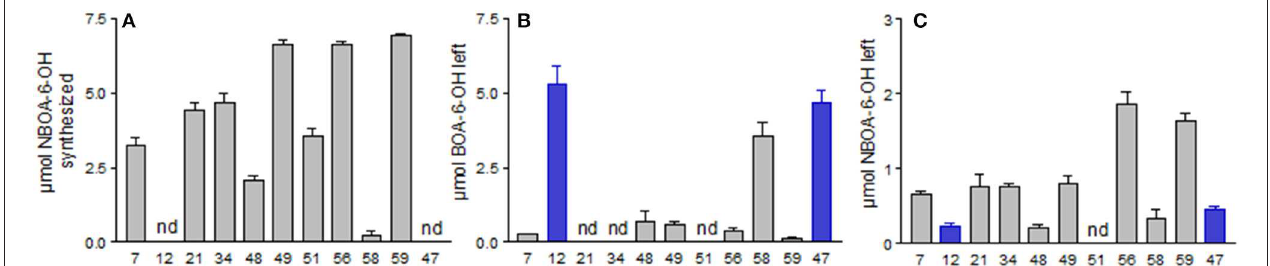
FIGURE 5 | Nitration of BOA-6-OH and degradation of NBOA-6-OH by the microorganisms. (A) Formation of NBOA-6-OH. (B) Residual 7 after 72h of incubation in the medium. (C) Residual NBOA-6-OH after 72h of incubation with the compound. Nd, not detectable. Microorganisms: Mycobacterium fortuitum (7), Bacillus aryabhattai (34), Bacillus cereus (59), Bacillus megaterium (21, 48), Bacillus methylotrophicus (58), Lysinibacillus xylanilyticus (56), Paenibacillus polymyxa (51), Aminobacter aminovorans (49), the fungi Papulaspora sepedonioides (12), and Trichoderma viride (47) . Blue bars, fungi; gray bars, bacteria.